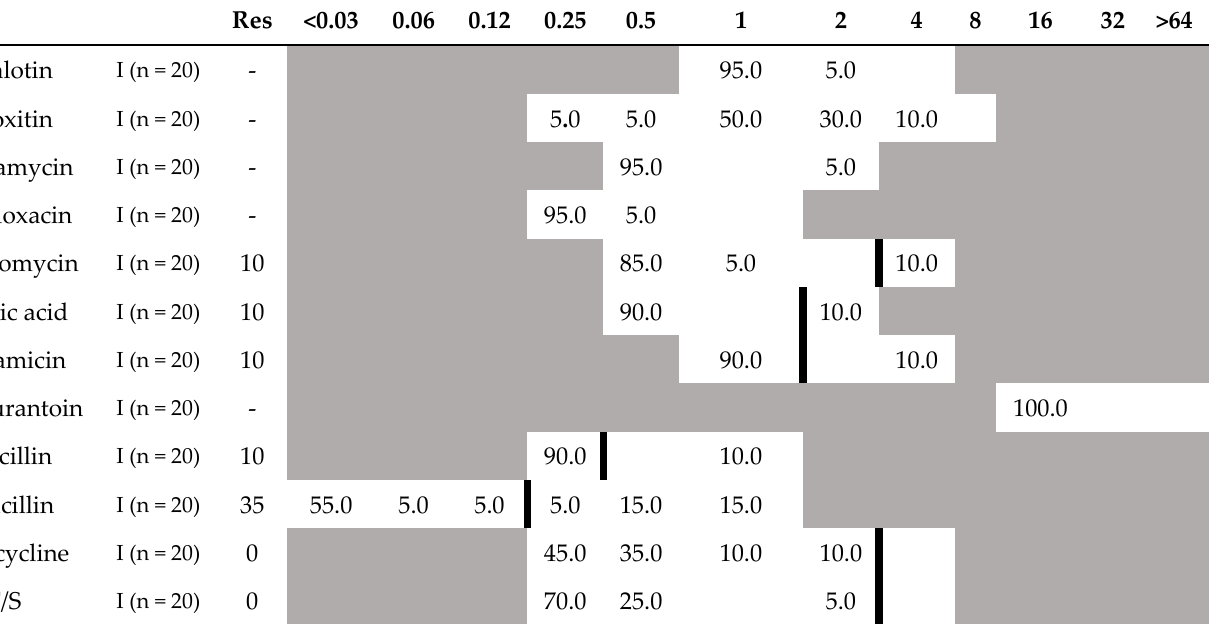
Table 4. Distribution of MICs (mg/L) and resistance of the 20 isolates of Staphylococcus spp. from the cranial vagina of inseminated mares (I). The results are shown as the percentage of isolates at